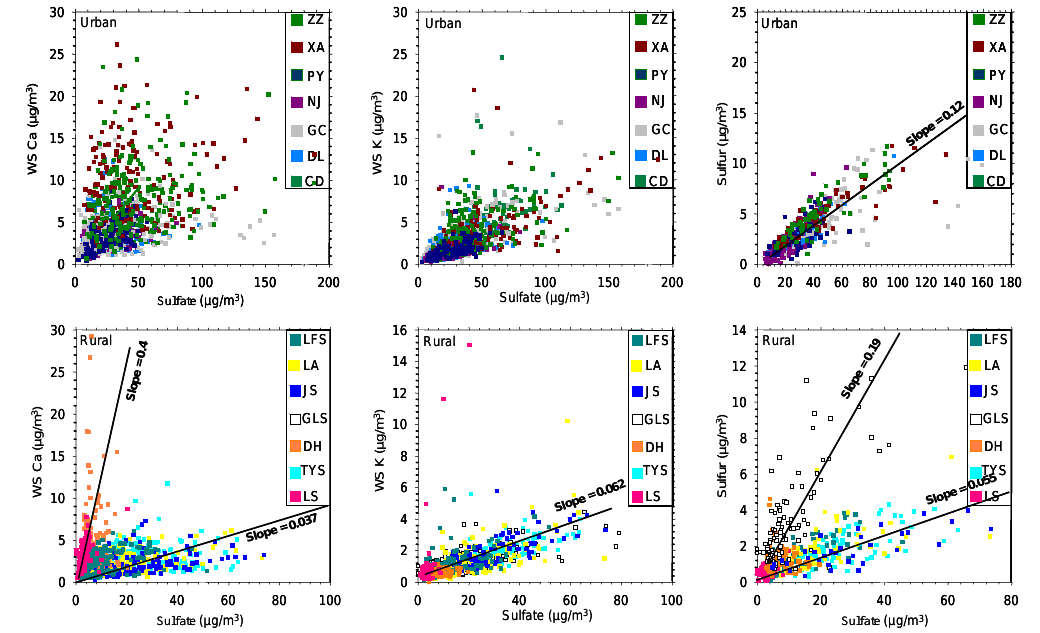
Fig. 8. Correlations among sulfate, water soluble Ca and K for urban and rural aerosols in